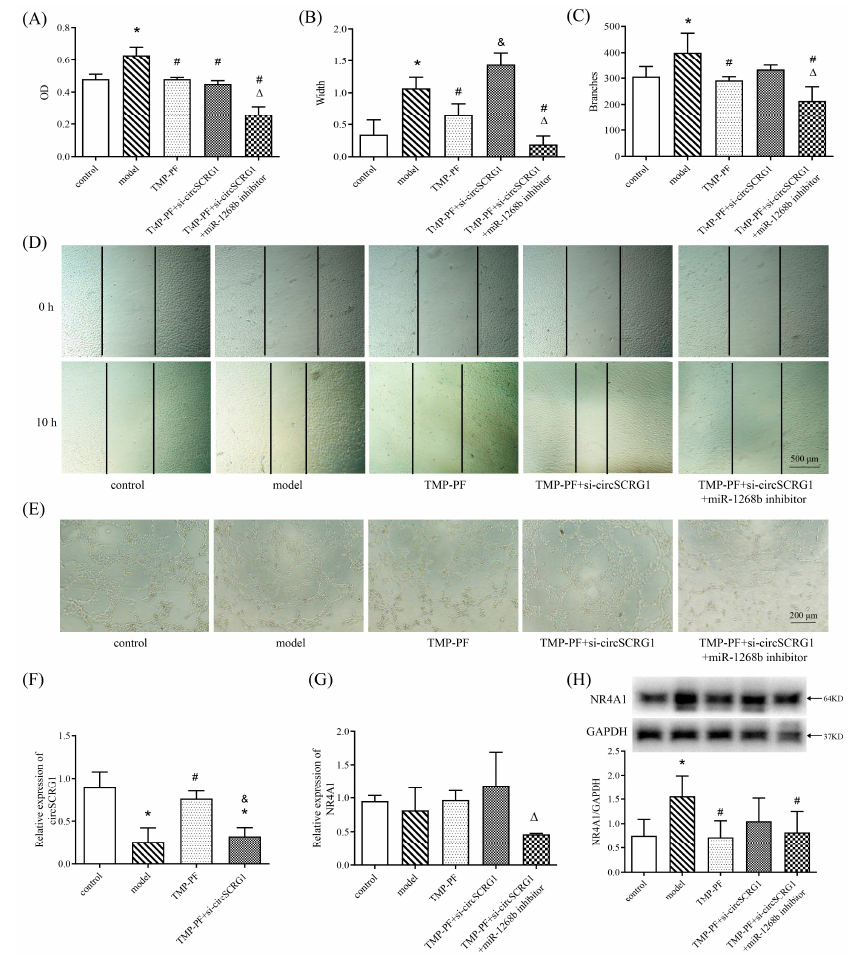
Figure 4 . TMP-PF suppressed ox-LDL-induced angiogenesis by regulating the circSCRG1/miR- 1268b/NR4A1 axis. ( A ) HUVECs were transfected with 100 nmol/L NC, miR-1268b inhibitor and/or si-circSCRG1 for 24 h, after which 20 μ g/mL ox-LDLs were added for 24 h to establish the model, and then the HUVECs were treated with TMP-PF (1 μ mol/L TMP combined with 10 μ mol/L PF) for 24 h. Cell proliferation was measured by an MTT assay and expressed as the OD value. ( B ) Quanti- fication of width, which represents cell migration, in wound healing assays. ( C ) Quantification of branch points, which represent tube formation, in Matrigel tube formation assays. ( D ) Representa- tive photomicrographs showing the migration of ox-LDL-induced HUVECs transfected with 100